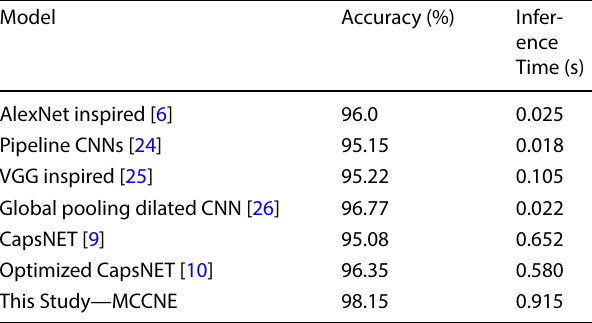
Table 3 Comparative analysis with existing methods